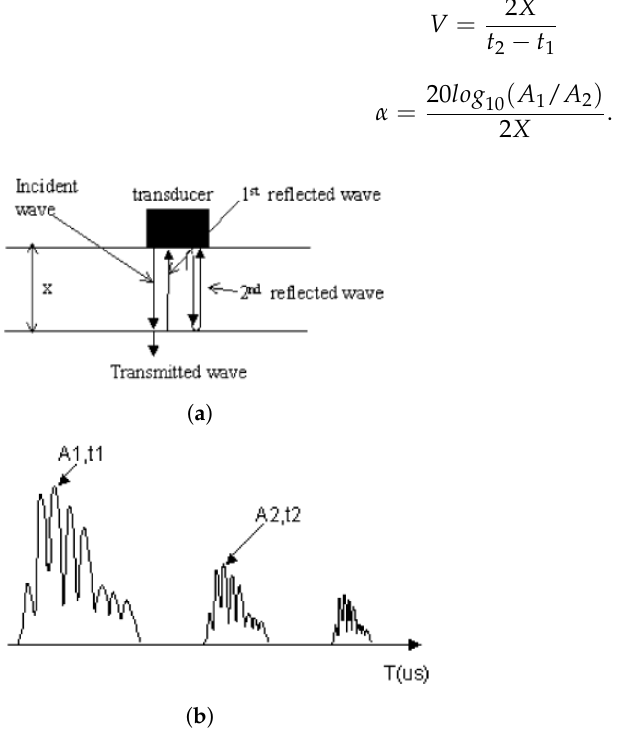
Figure 3. ( a ) Ultrasound propagation; ( b ) Ultrasound echo signals